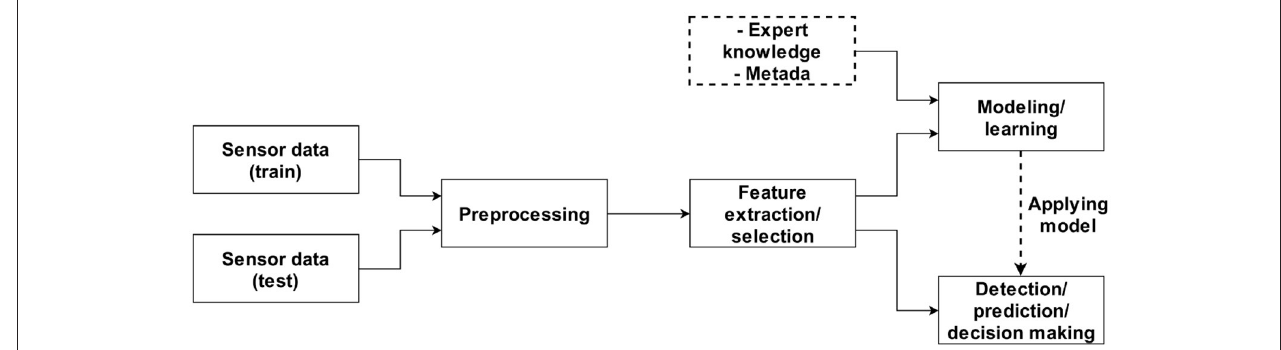
FIGURE 4 | Stages of data and signal processing